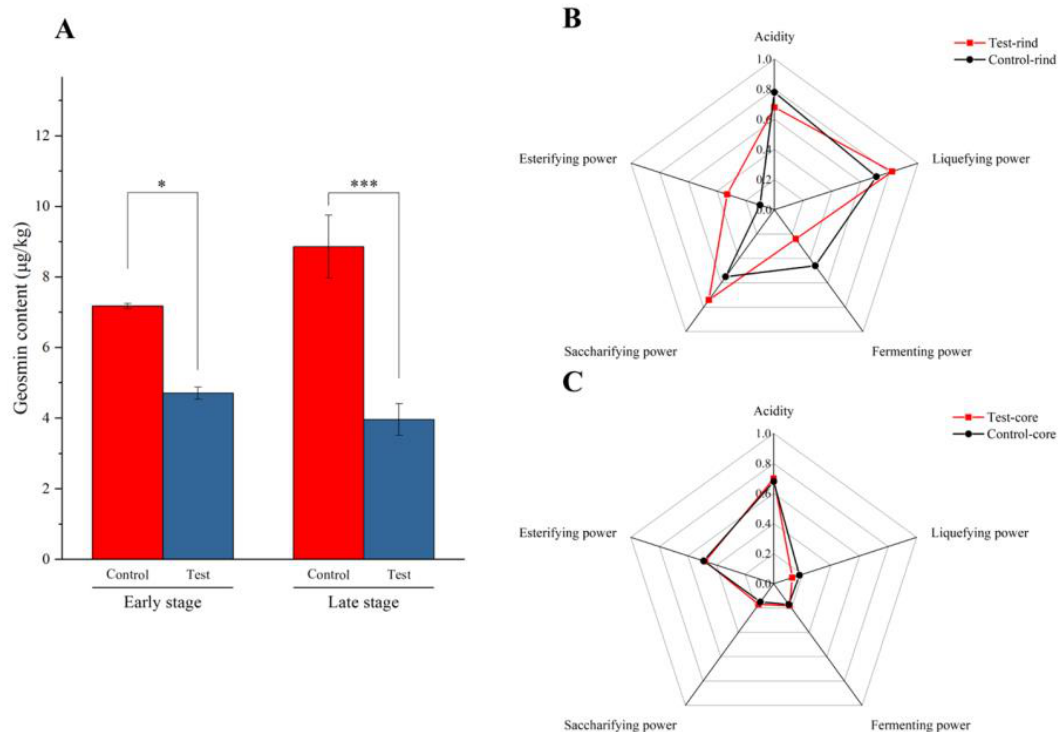
Figure 2. ( A ) Geosmin content in the early stage and late stage during Daqu incubation. *, P < 0.05; ***, P < 0.001. ( B ) The physicochemical characteristics in the rind of the Daqu . ( C ) The physicochem- ical characteristics in the core of the Daqu . The red line represents the test group; the black line rep- resents the control group.